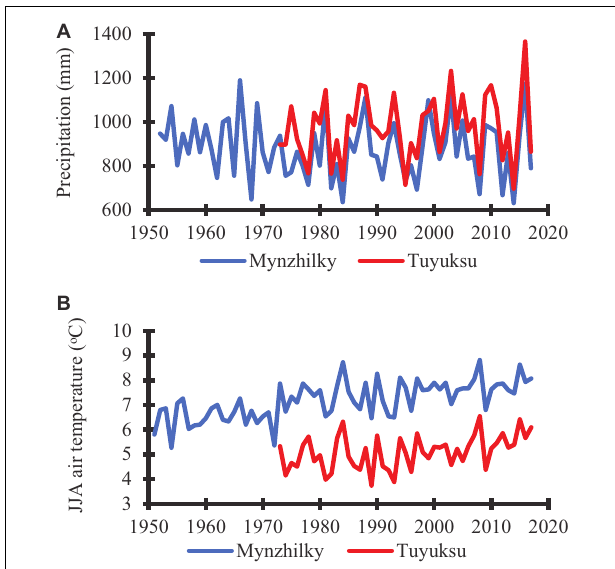
FIGURE 9 | (A) Annual precipitation calculated for mass balance year (October–September) and (B) June–July–August temperature at the Mynzhilky (3,100 m a.s.l.) and Tuyuksu (3,438 m a.s.l.) stations.